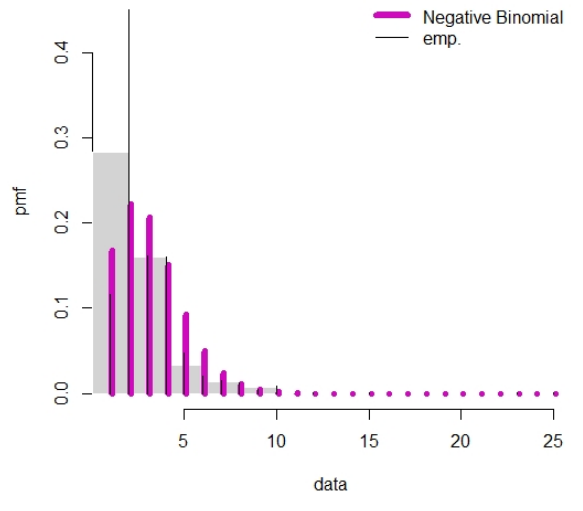
Figure 9. Fitted plots of BNDL and BDLD distribution for given data set.